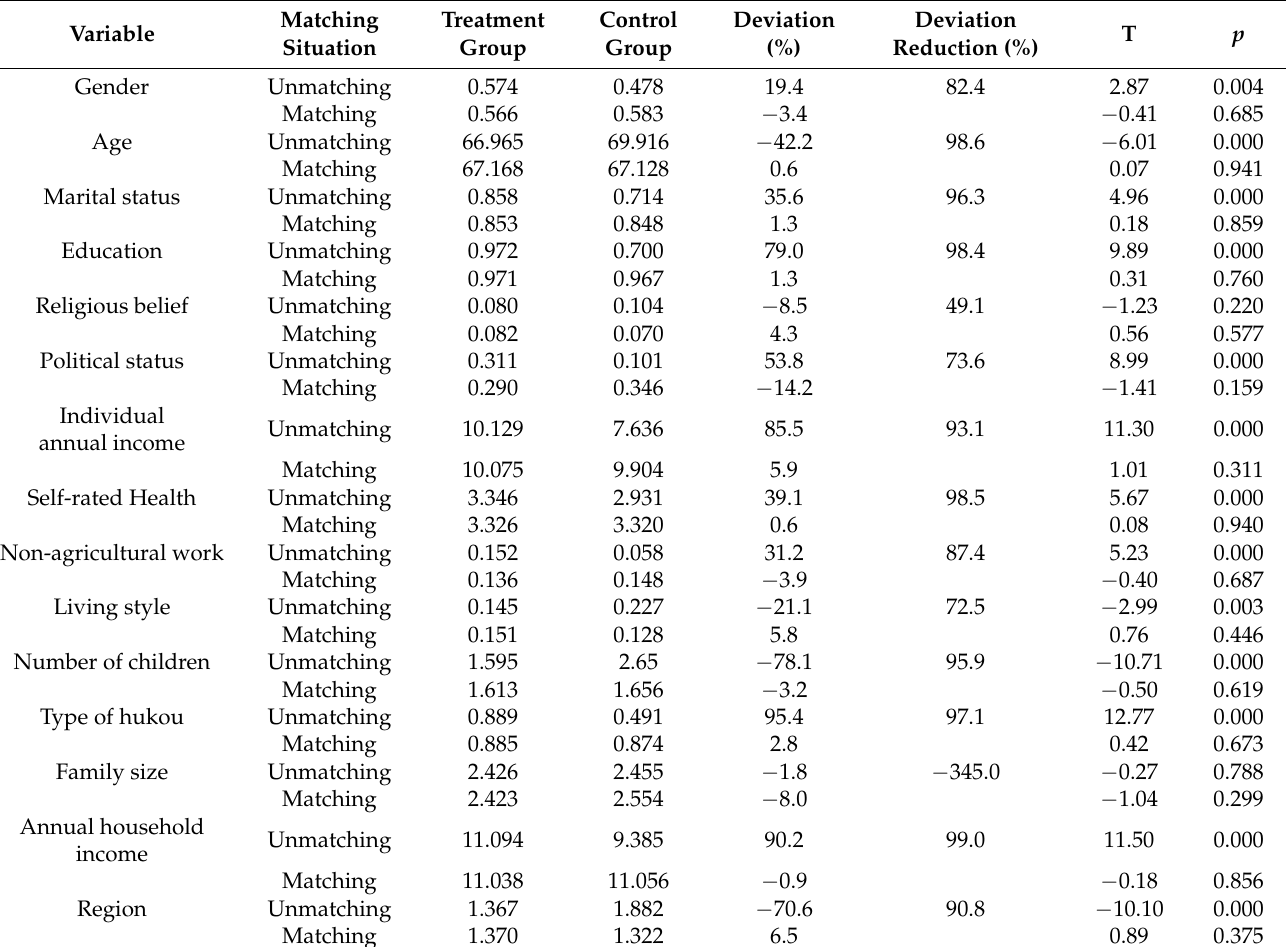
Table 3. Sample balance